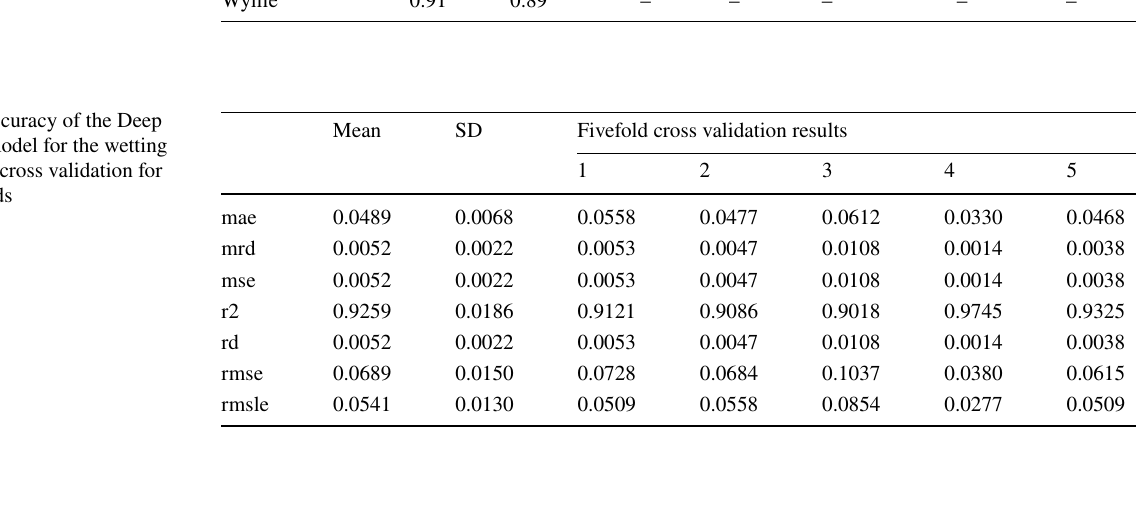
Fig. 2 Water fractional flow curve with its derivative for the field